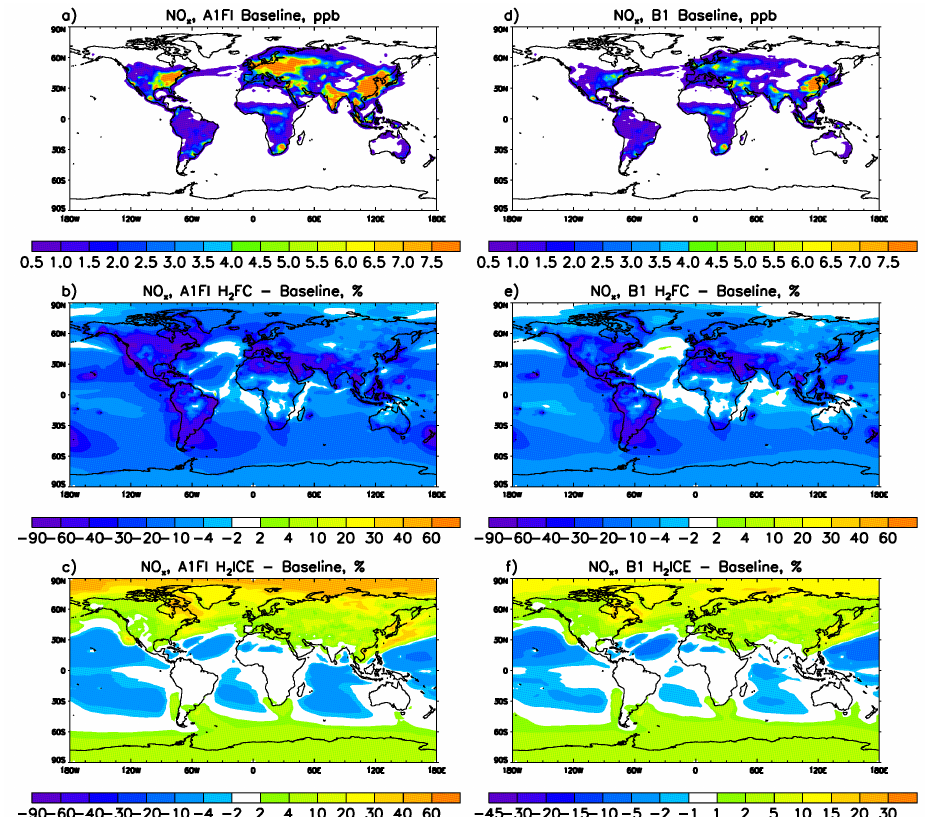
Figure 8. CAM-Chem simulated 2050 annual mean surface NO Fig. 8. CAM-Chem simulated 2050 annual mean surface NO x mixing ratios in the A1FI (a) and B1 (d) baseline scenarios and percent differences for the H 2 fuel cell (H 2 -FC) and H 2 internal combustion engine (H 2 -ICE) scenarios (b, c, e, f) . Note the different and B1 (d) Baseline scenarios and percent differences for the H 3 Internal Combustion Engine (H